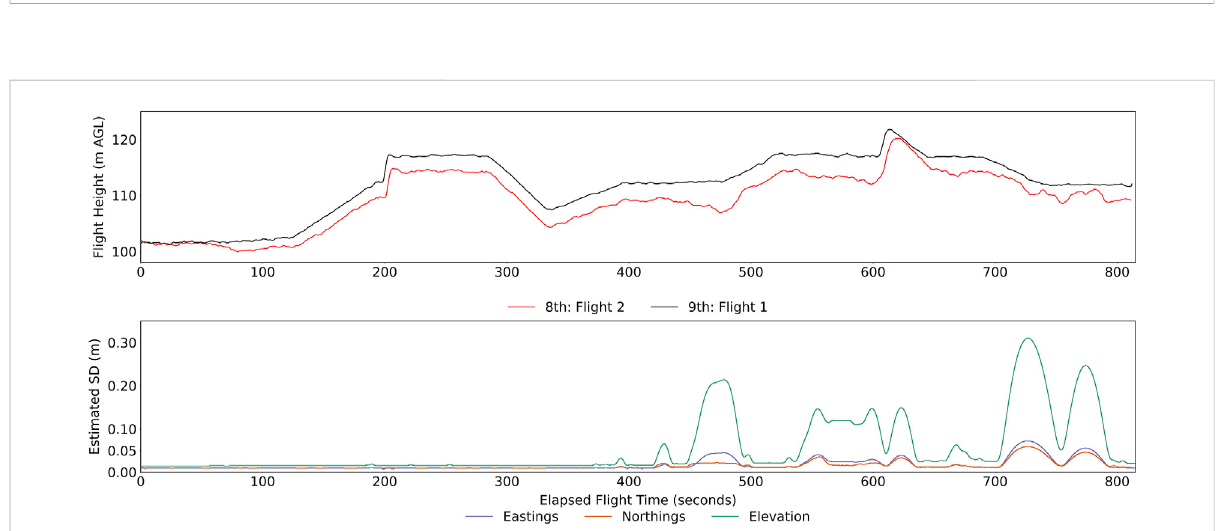
FIGURE 5 The top panel illustrates the post-processed elevation of the sensor throughout the survey for both F2 on the 8 th and F1 on the 9 th . Whilst F1 on the 9 th maintains steady elevations and smooth transitions between different prescribed fl ight heights, F2 on the 8 th does a much poorer job comparatively, especially towards the end of the fl ight. The below panel shows estimated standard deviations in positional accuracy for Eastings, Northings, andElevation,throughout theduration ofF2onthe8thJuly. The positionoftheUAV isresolvedwell untilmidwaythroughthe fl ight where greater uncertainty in the post-processed position appears, with similar uncertainty in the Eastings and Northings data of around 0.05 m, but with up to 0.31 m in the Elevation data. This coincides with the increased variability of the post-processed elevation data, providing further basis to remove this survey from our